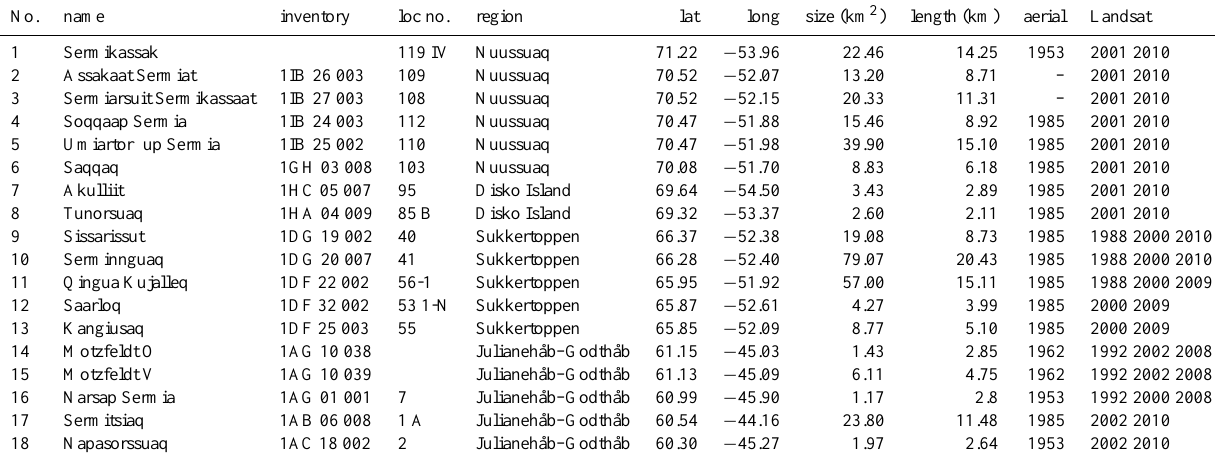
Table 1. Number, name, inventory numbers in Weidick et al. (1992) (inventory) and Weidick (1968) (loc no.), region, latitude (lat), longitude (long), glacier area (size), length along flow line (length), and years with information used for extending Weidick (1968): digitized glaciers outlines from aerial photography (aerial) and USGS Landsat images (Landsat). Glacier area and length are derived from the 2000, 2001, or 2002 glacier outlines. We have used the new Greenlandic spelling of the glacier names, which slightly differs from the old spelling used in Weidick